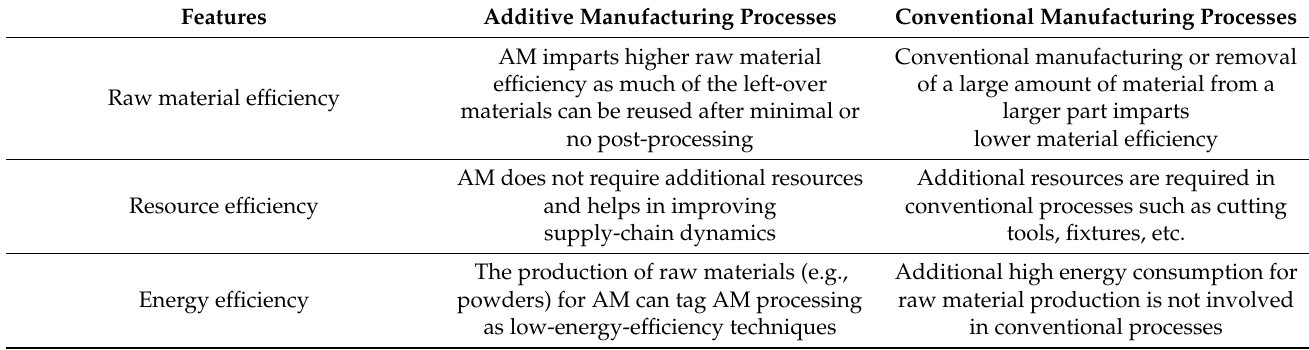
Table 4. Summary of additive vs. subtractive manufacturing processes